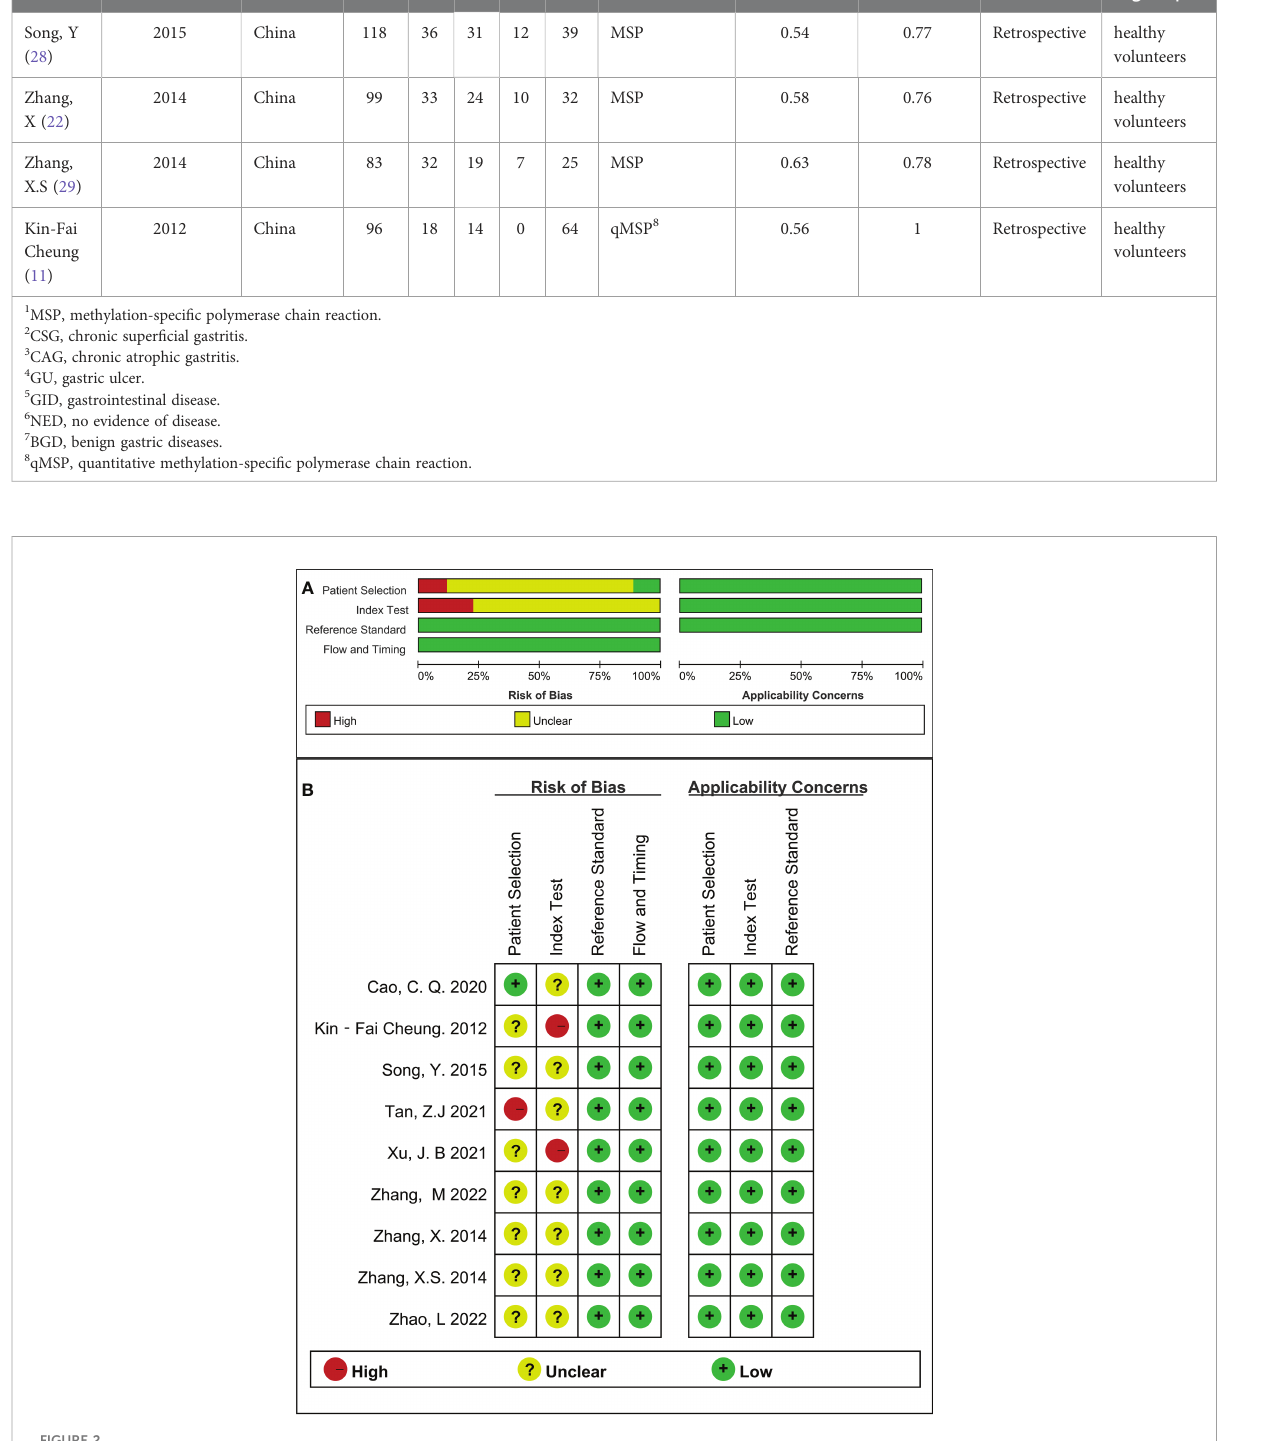
FIGURE 2 Quality assessment results (A) : Summary of methodological quality; (B) : Methodological quality